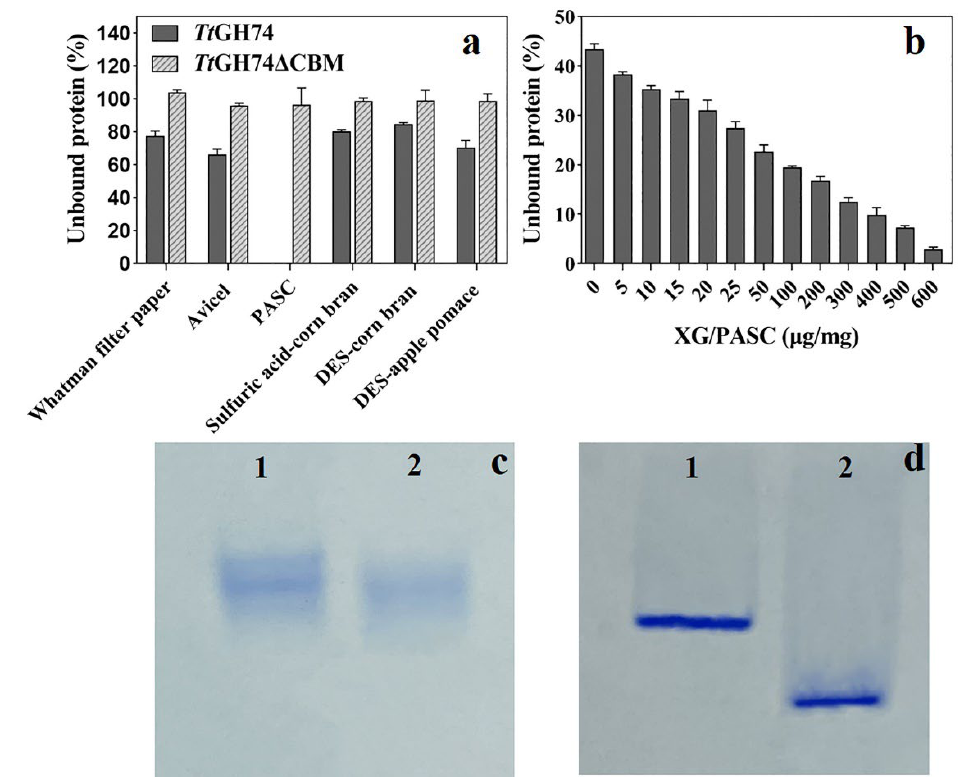
Figure 4. The adsorption differences of Tt GH74 and Tt GH74 ∆ CBM on various celluloses and lignocelluloses ( a ), the adsorption of Tt GH74 on cellulose with different proportions of XG ( b ) and analysis of their adsorption capacities on XG by electrophoresis in 7.5% native polyacrylamide gel without xyloglucan ( c ) or with 0.005 w/v xyloglucan ( d ). Lane 1, Tt GH74; and Lane 2, Tt GH74 ∆ CBM. Table 3. The chemical composition of the pretreated corn bran and apple pomace substrates. Lignin Glucose Xylose Galactose Mannose Arabinose